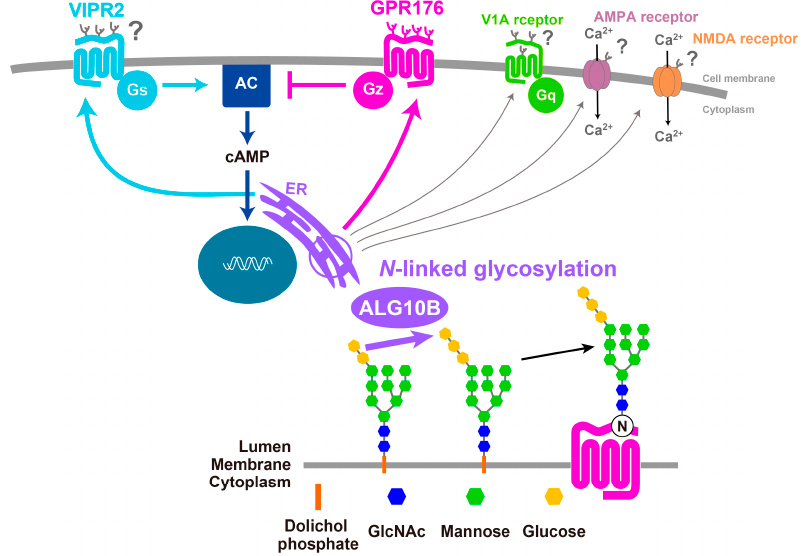
Figure 5. Possible roles of ALG10B-mediated N -glycan modification in the SCN. ALG10B is an enzyme catalyzing the addition of the terminal glucose residue to the growing N -glycan in the endoplasmic reticulum (ER). N -glycosylation occurs not only on GPR176 but also on other clock-related GPCRs and non-GPCR membrane proteins.